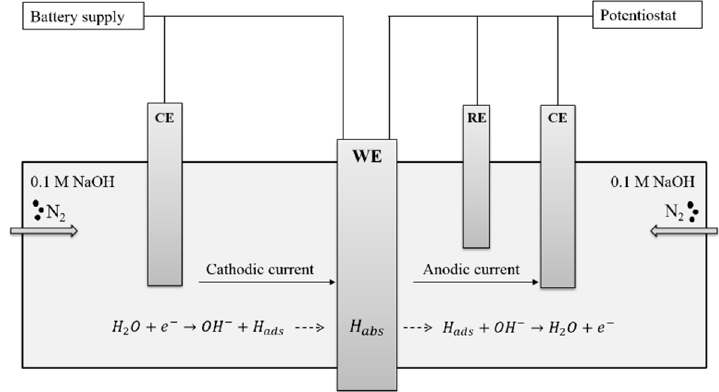
Figure 1. Schematic representation of the permeation set-up where hydrogen is produced at the cathodic side of the cell ( left ) and after diffusion through the working electrode (WE) is oxidized at the anodic side of the cell ( right ). Reference electrode and counter electrode are labeled as RE and CE, respectively.